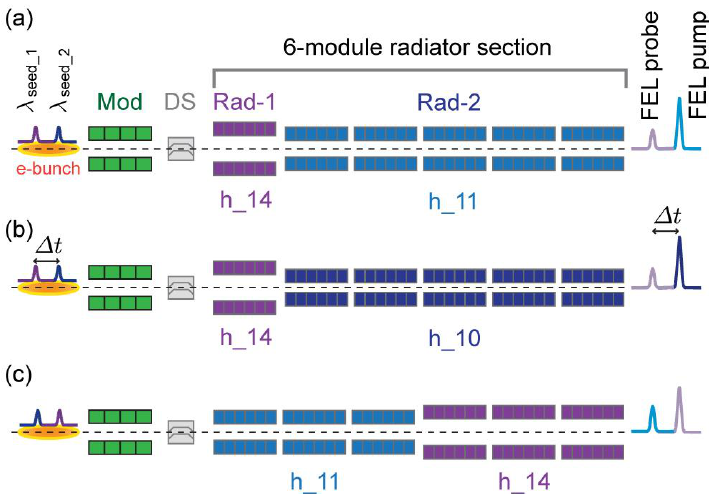
Figure 1. Twin-seed split-radiator source scheme. ( a ) Ni-3p resonant probe, Fe-3p resonant pump. The two UV seed pulses, controlled in intensity and separated by a well-defined time delay ∆ t , interact with the electron bunch within the modulator (Mod) section. After going through the dispersive section (DS), the electron excitation induced by the probe seed pulse ( λ seed_1 = 261.5 nm) is amplified by the first of the six radiator modules (Rad_1) tuned to harmonic 14 (h_14), generating 18.6 nm free-electron laser (FEL) radiation (67 eV, Ni-3p resonance). This excitation is not amplified by the five other radiator modules (Rad_2). Conversely, the UV pump seed ( λ seed_2 = 255 nm) induces an excitation of the electron bunch that is amplified by tuning Rad_2 to the 11th harmonic, generating a 23.2 nm FEL pulse (53.5 eV, Fe-3p resonance), but this excitation is not amplified by Rad_1. The source delivers two FEL pulses tuned in energy to the Fe-3p and Ni-3p resonances, with controlled intensities and time separation; ( b ) Ni-3p resonant probe, non-resonant pump. The same seeding scheme as in ( a ) applies, but the Rad_2 radiator sub-section is tuned to h_10 of the 255 nm pump seed, generating 25.5 nm FEL radiation, whose photon energy is insufficient to photo-excite the core electrons of either Fe or Ni; ( c ) Fe-3p resonant probe, Ni-3p resonant pump. The wavelengths of the two UV seeds are inverted ( λ seed_1 = 255 nm, λ seed_2 = 261.5 nm) and the radiator is split in two sub-sections of three modules each. Rad_1 provides the 23.3 nm FEL probe pulse tuned to the Fe-3p resonance, while Rad_2 generates the Ni-3p resonant 18.6 nm pump